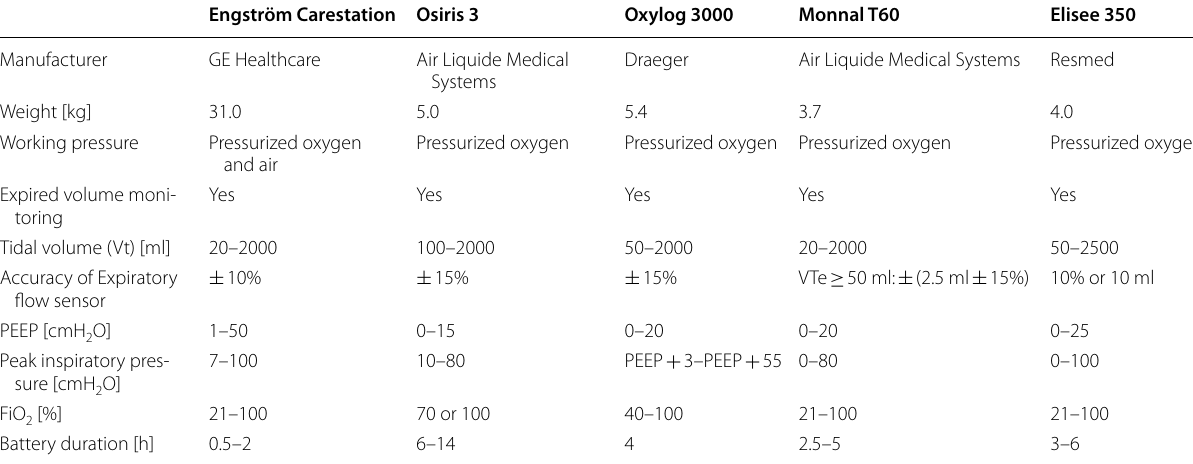
PEEP positive end expiratory pressure, FiO 2 fraction of inspired